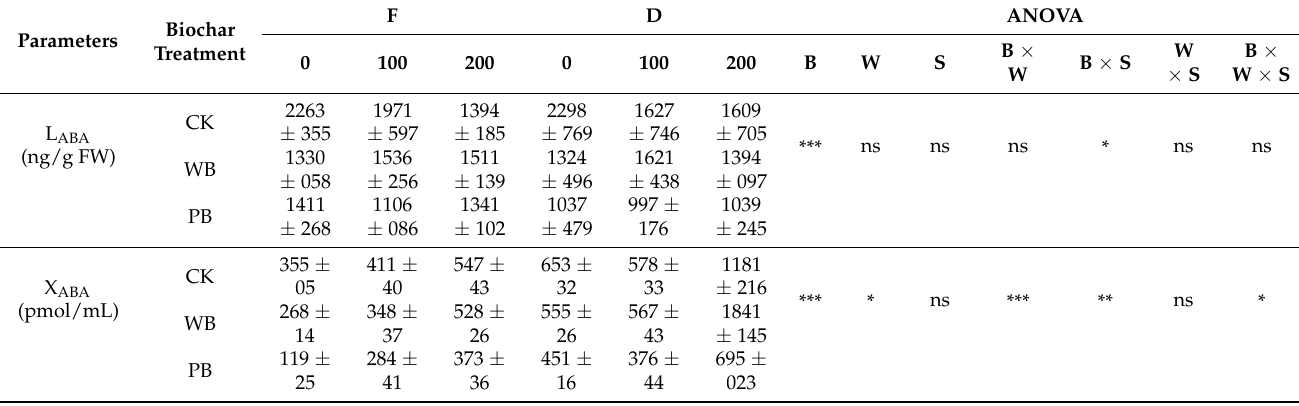
Table 5. Effect and output of three-way ANOVA for leaf ABA concentration (L ABA ) and xylem sap ABA concentration (X ABA ) as affected by biochar addition (B), drought stress (W), and salt stress